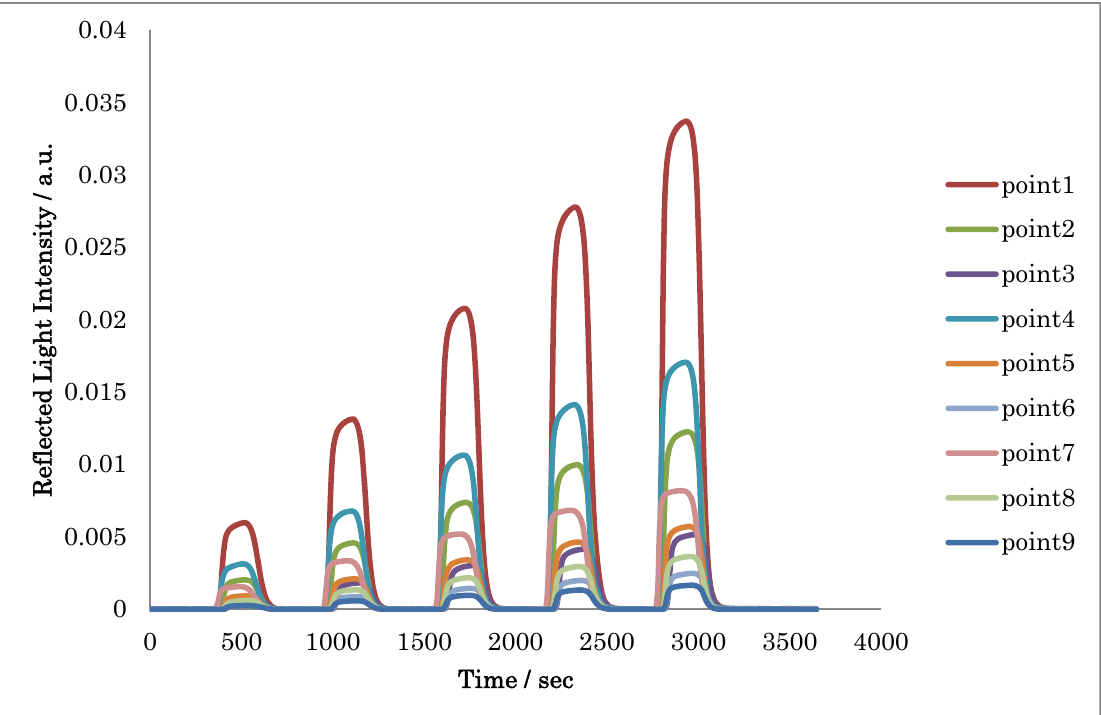
Figure 8. The 2D SPR sensorgrams for sucrose solutions.